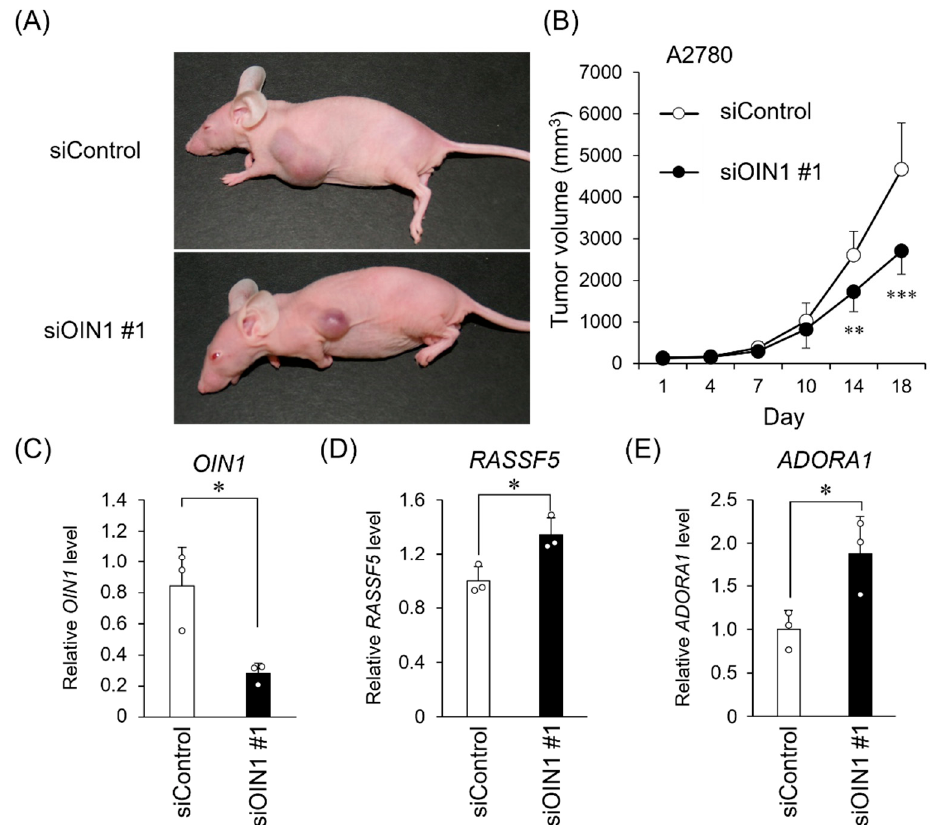
Figure 4. OIN1 siRNA inhibits tumor formation of ovarian cancer xenografts. ( A ) Athymic mice were subcutaneously xenografted with A2780 cells and, then, siOIN1 #1 ( n = 8) or siControl ( n = 7) was injected into the tumors twice a week. Representative images of generated tumors after 18 days are shown. ( B ) Tumor volumes are presented as mean ± SD. ( C – E ) Relative expression levels of OIN1 RNA ( C ), RASSF5 ( D ), and ADORA1 ( E ) mRNAs in the tumors dissected 18 days after the start of siRNA injection were quantified by qRT-PCR and normalized to GAPDH mRNA levels. Data are presented as mean fold change ± SD versus siControl in tumors (siControl, n = 3; siOIN1 #1, n = 3). * , p < 0.05; ** , p < 0.01; *** , p < 0.001; Student’s t -test.